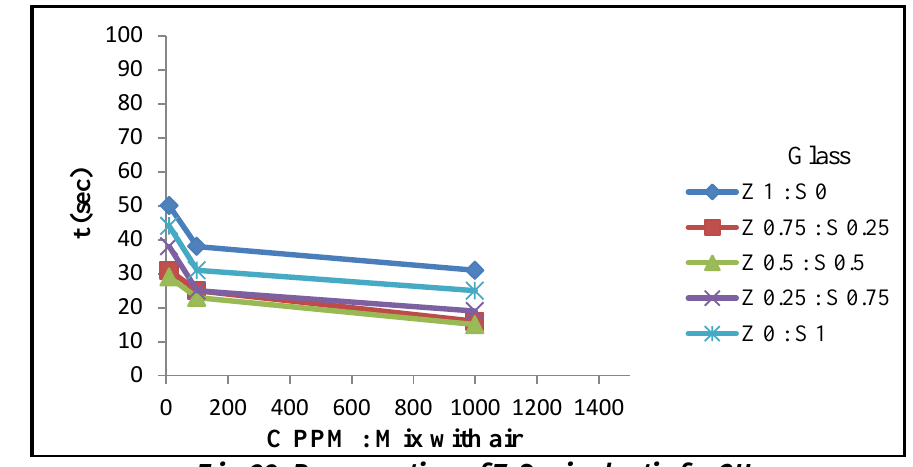
Fig. 20: Response time of Z:S mixed ratio for CH